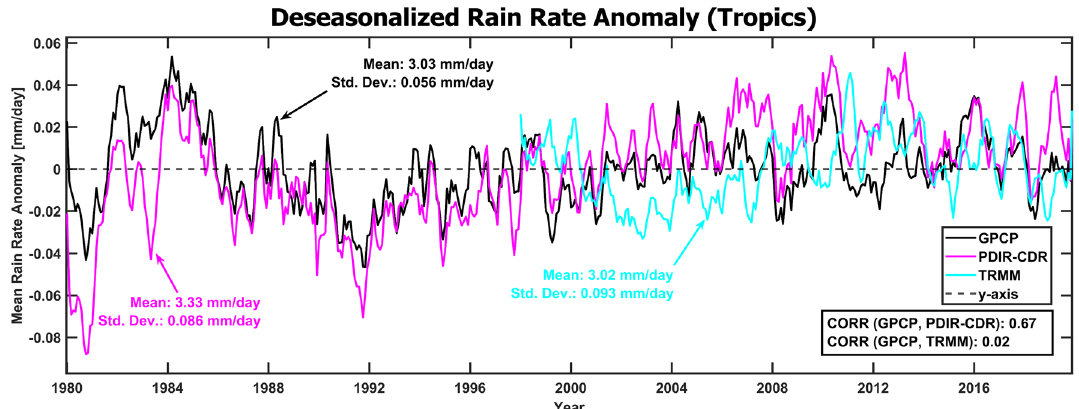
Figure 7. Deseasonalized rain anomalies over the tropics (30°N to 30°S) from GPCP v2.3 (black), PDIR-CDR (magenta), and TRMM TMPA-34BT v7 (cyan), measured at the monthly scale. Each data set is described by its mean value and standard deviation over the domain in the colored arrows. Correlations between PDIR-CDR and TRMM with GPCP are reported in the bottom right